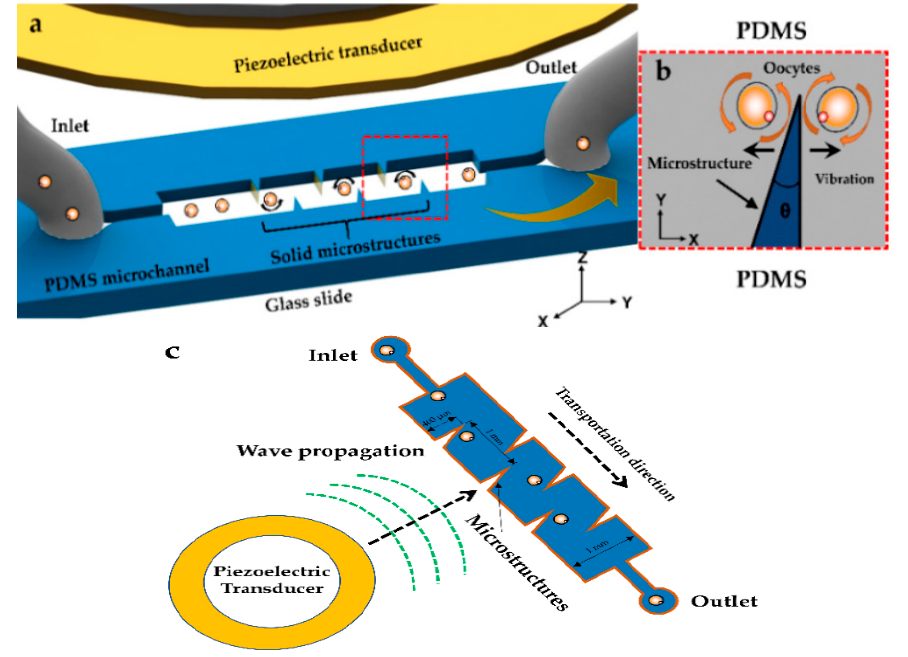
Figure 1. Design of the rotational device using acoustic waves: ( a ) conceptual overview of the microfluidic chip and ( b ) oscillations of the solid microstructures used for cell rotation; ( c ) working principle and typical geometric dimensions of the acoustofluidic rotational manipulation device.